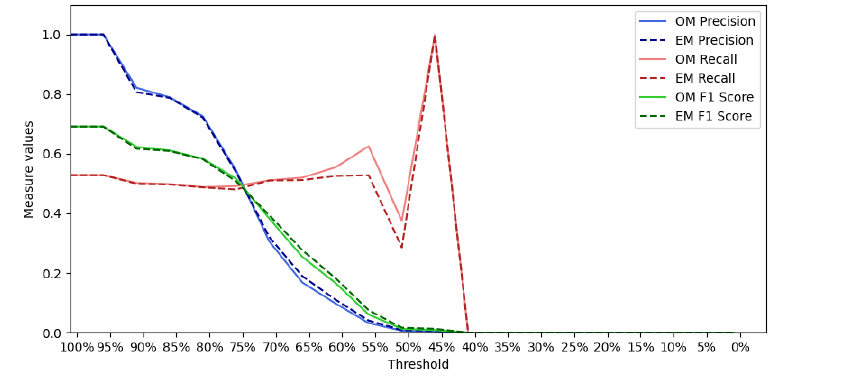
Figure 14. Results of the event “Ottawa